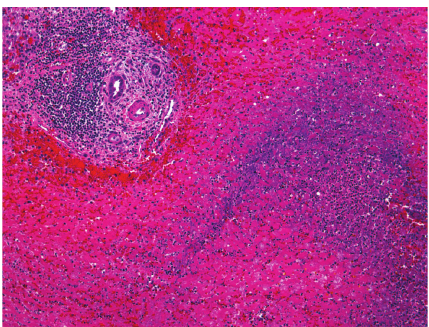
Figure 4: Photomicrograph of explanted liver demonstrating massive necrosis and architectural